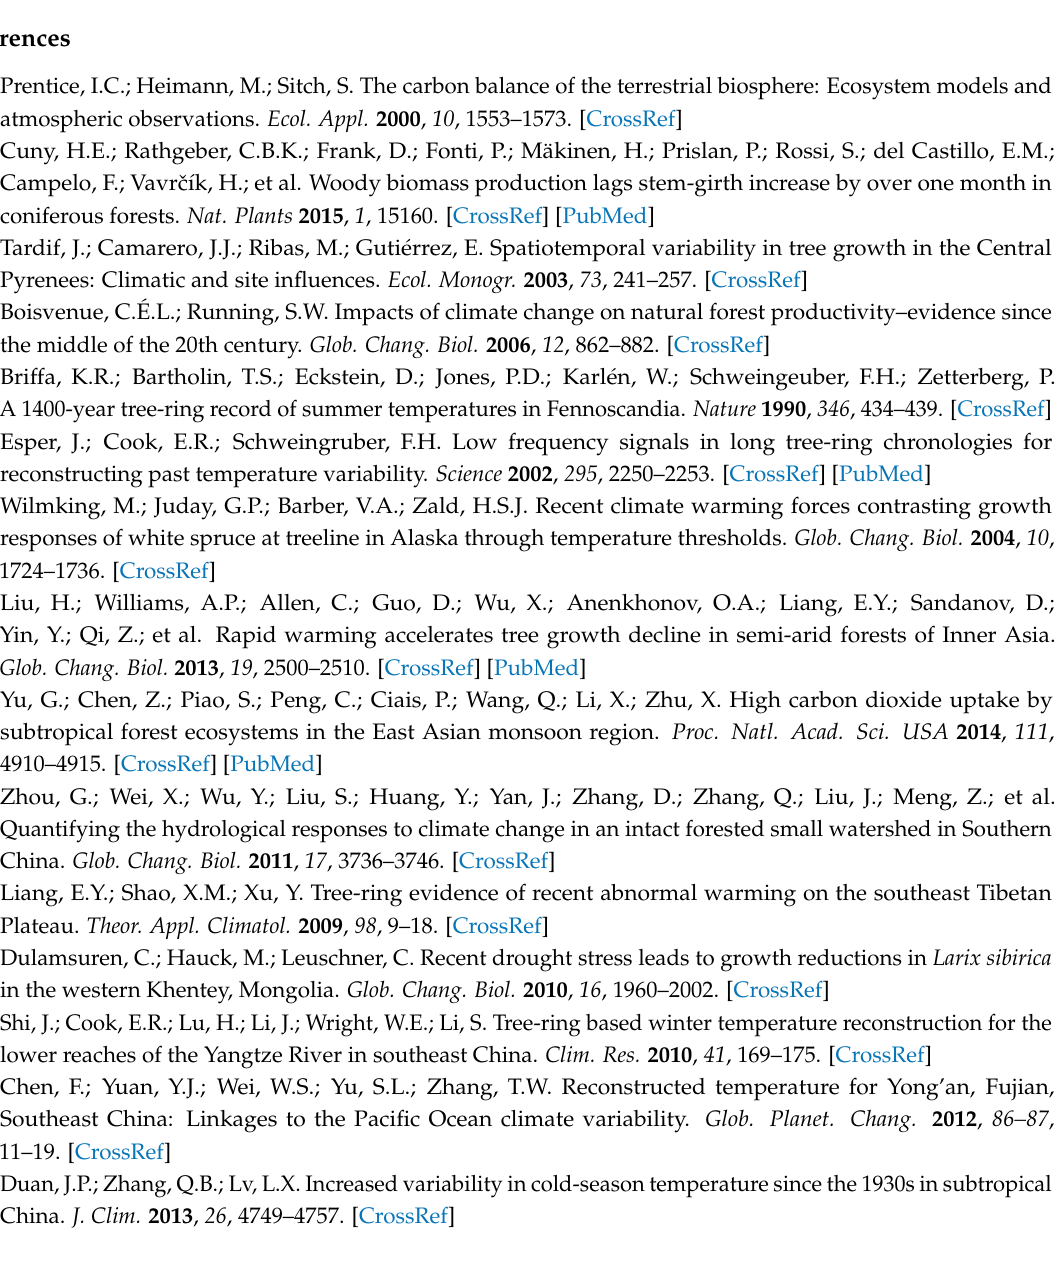
Figure S1: Moving correlations (21 days window) between stem increments and minimum air (a,c) and soil (b,d) temperatures during the growing seasons in 2016 and 2017. Spearman correlations were calculated for relationships between stem increments and temperature variables. Horizontal thin dashed lines indicate the significance level at p = 0.05. Vertical thick dashed lines indicate the timing of shifts in the correlations between stem increments and temperature variables. The shaded regions indicate the growing